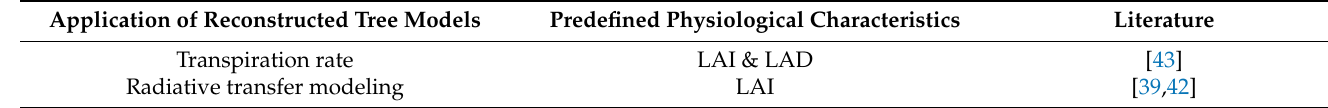
Table 10. Literature using predefined physiological characteristics for specific